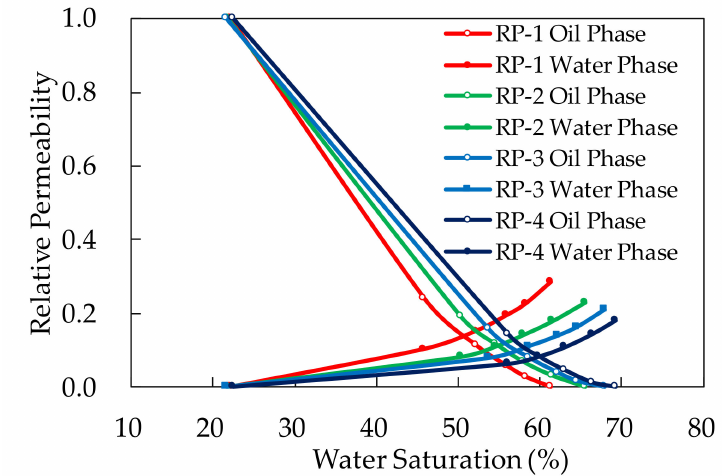
Figure 8. The relative permeability curves of polymer flooding calculated by the improved J.B.N.